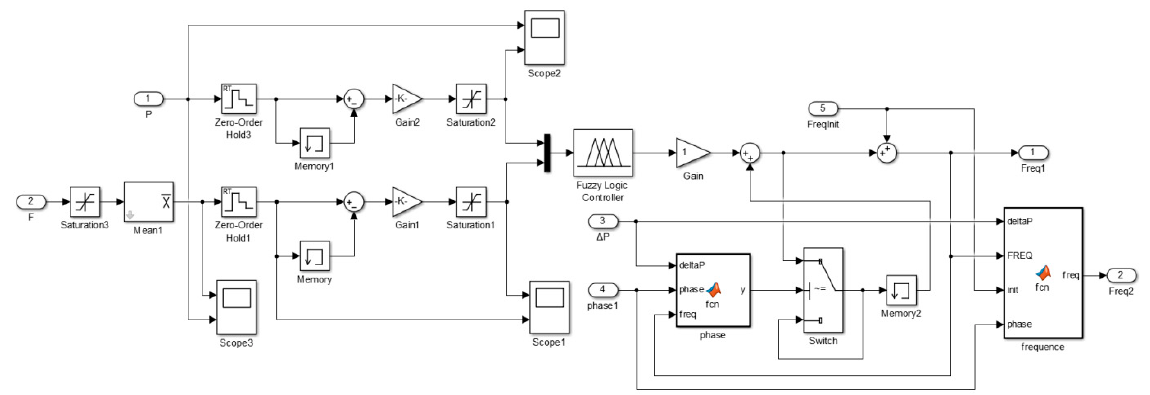
Figure 13. Internal structure of a fuzzy PFM controller.